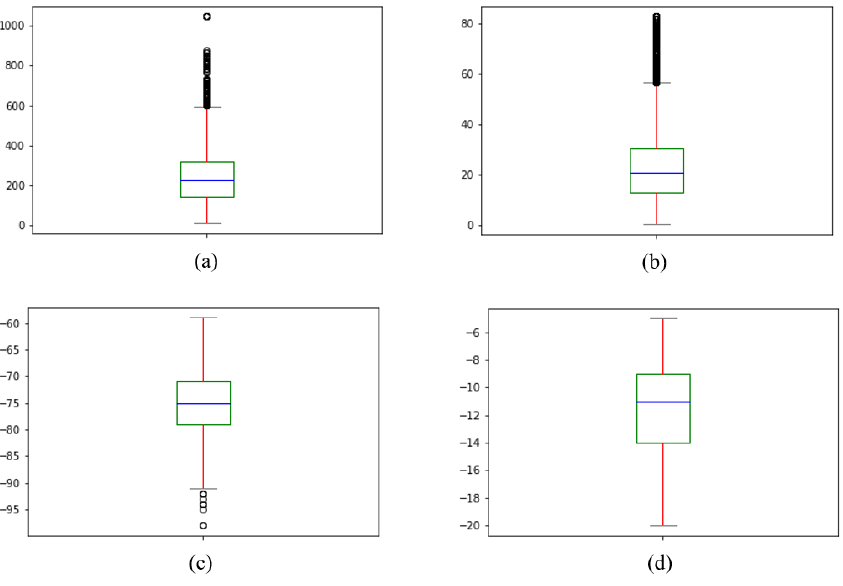
Figure 10. Box plots of ( a ) distance, ( b ) angle, ( c ) RSRP, and ( d ) RSRQ.